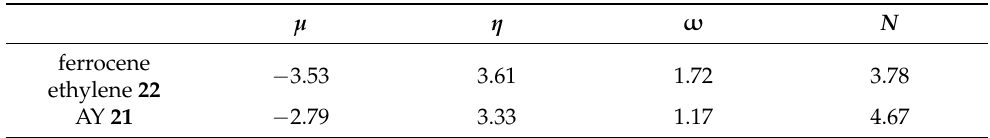
Table 1. B3LYP/6-31G(d) electronic chemical potential µ , chemical hardness η , electrophilicity ω , and nucleophilicity N indices, in eV, of AY 21 and ferrocene ethylene 22